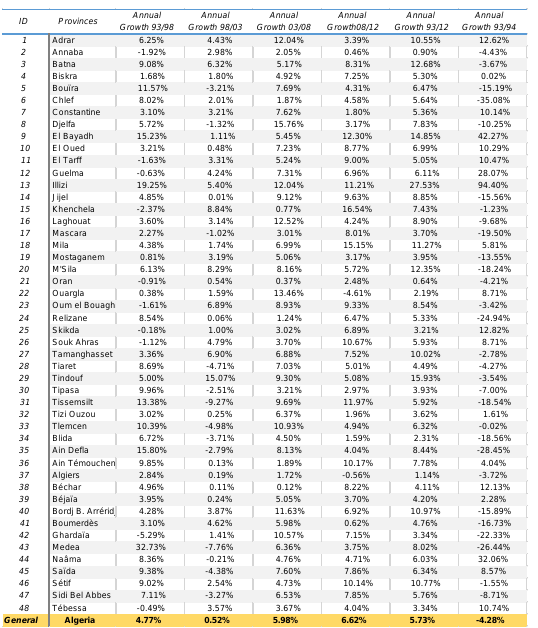
Table 2. Annual growth of nighttime light in Algerian provinces between 1993-2012.